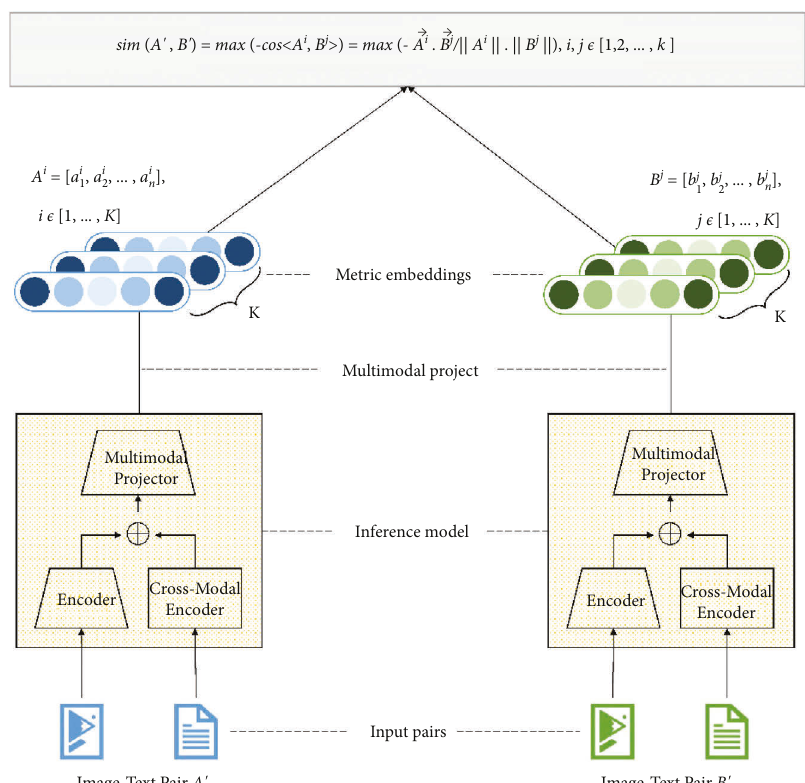
Figure 4: The architecture and processing process in inference.